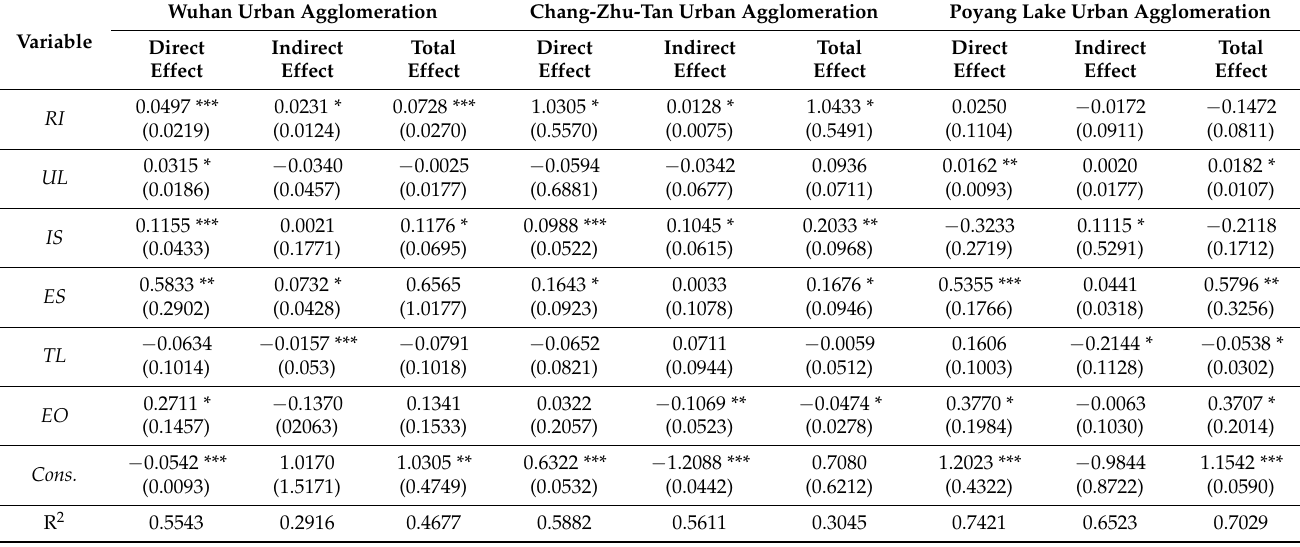
Table 5. Decomposition of urban green development effects of regional